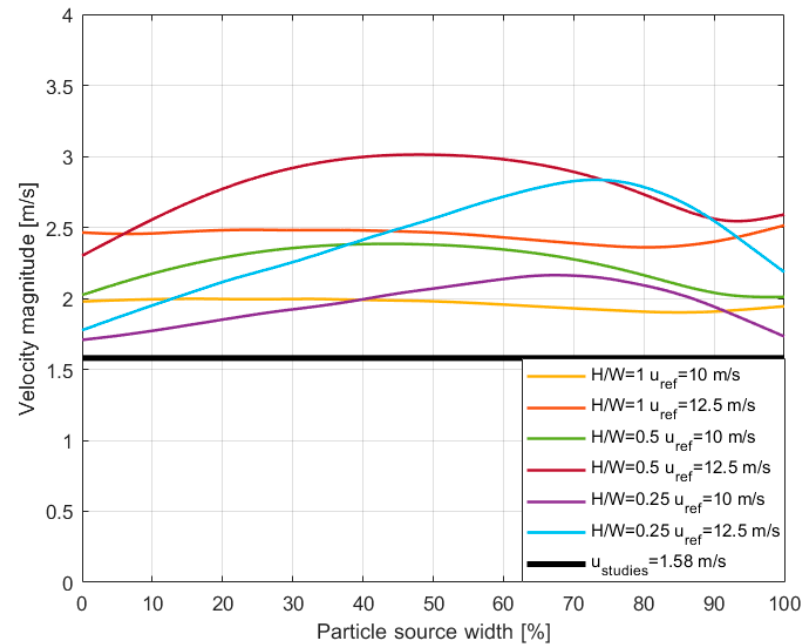
Figure 7. Velocity magnitude at a height of 2 m in all the simulated cases, above the surface where u ∗ t was exceeded. For the purpose of comparison, the source width is expressed as a percentage.